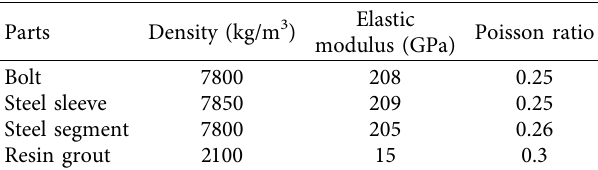
Table 2: Material parameters of the numerical calculation model.